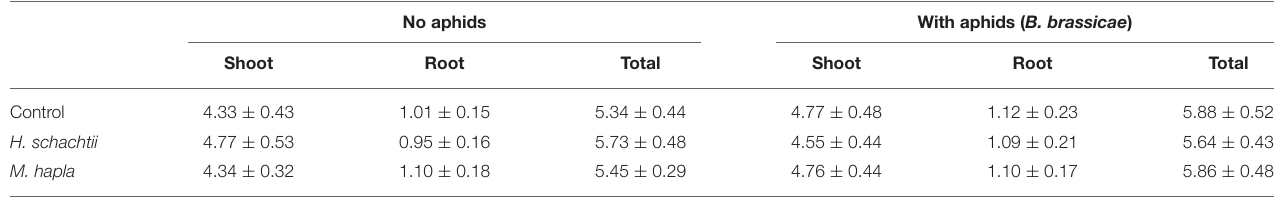
TABLE 3 | Brassica nigra shoot, root and total plant biomass (g dry mass) ± SEM at 16 days after infestation with Heterodera schachtii or Meloidogyne hapla of plants with and without 9 days of aphid ( Brevicoryne brassicae ) feeding. No aphids With aphids ( B. brassicae )